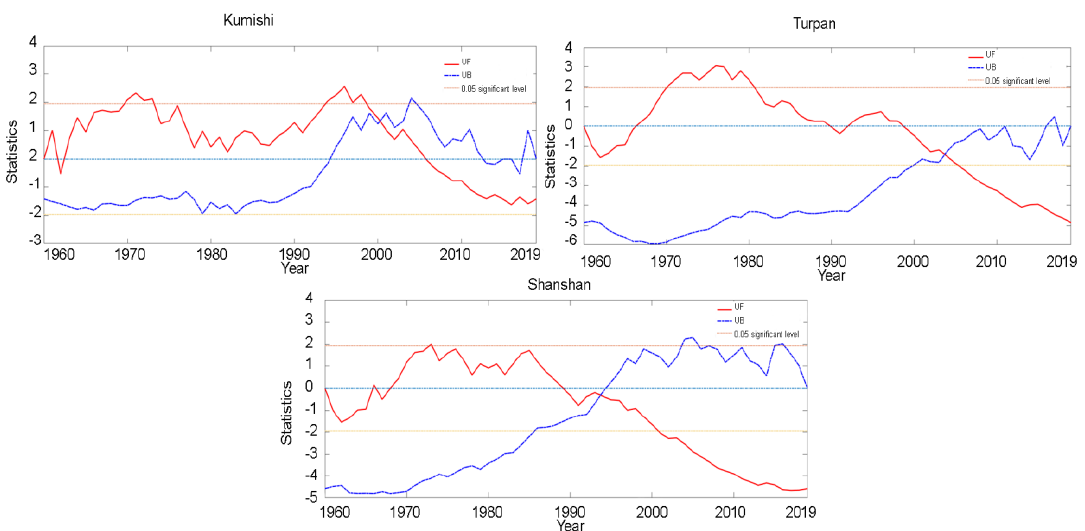
Figure 9. M–K mutation test curves for Turpan region annual scale SPEI indices 1960–2019.